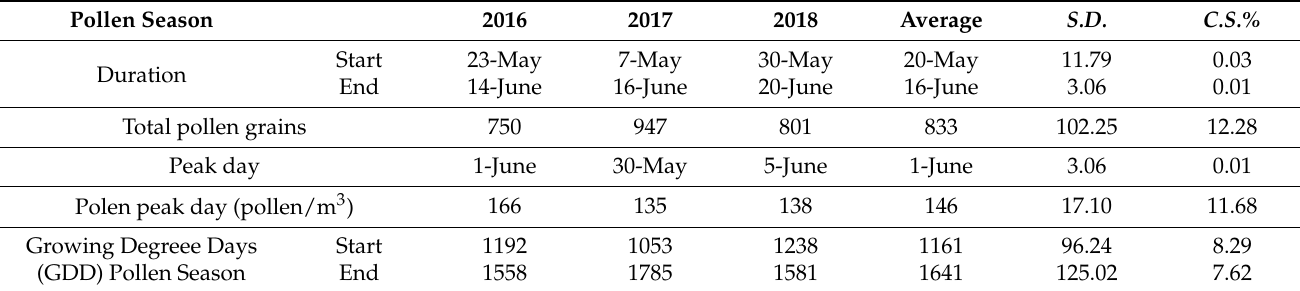
Table 2. Start and end date of the atmospheric Olea pollen season (days), total pollen amount (pollen/m 3 ), peak day, concentration on peak day and total heat requirements for the start and end date of the pollen season. Average, standard deviation (S.D.) and standard deviation in percentage (C.S. %).